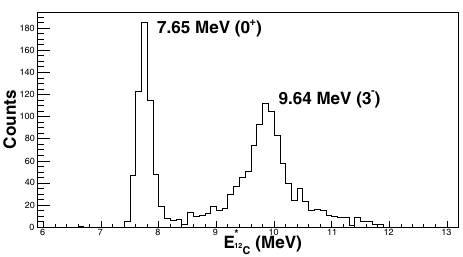
Figure 3. Excitation energy spectrum of 12 C ∗ in which 16 O ∗ de- cays with the emission of an α particle.